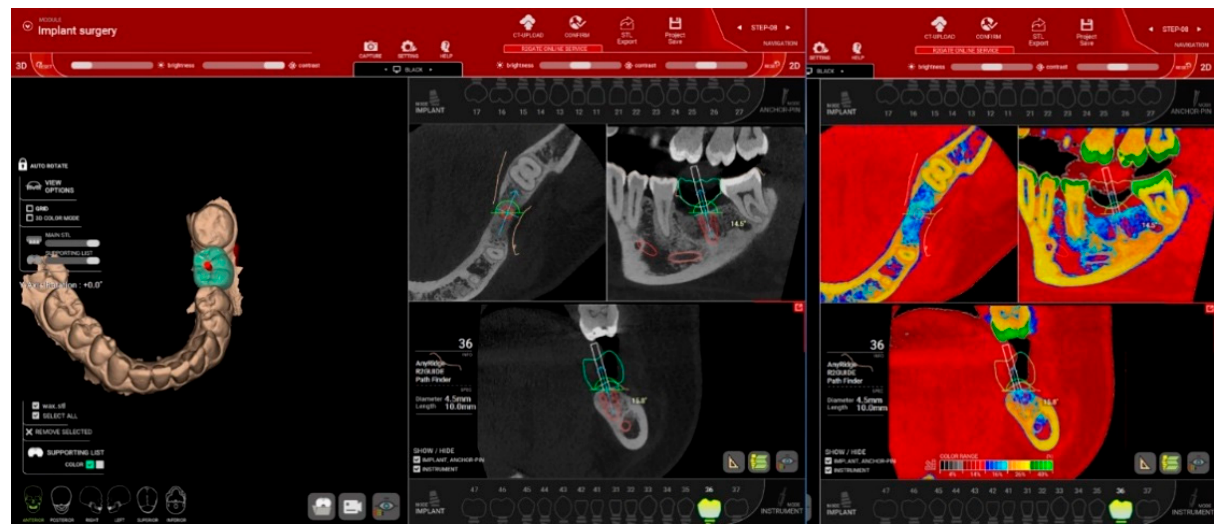
Figure 3. Planning implant directions, length and diameter in R2GATE software taking into consideration the final restoration and the available bone volume and quality. To facilitate bone quality assessment the “Digital Eye” option of the software (right) provides automatic conversion of CBCT gray scale in 5 basic colors, for bone density evaluation.